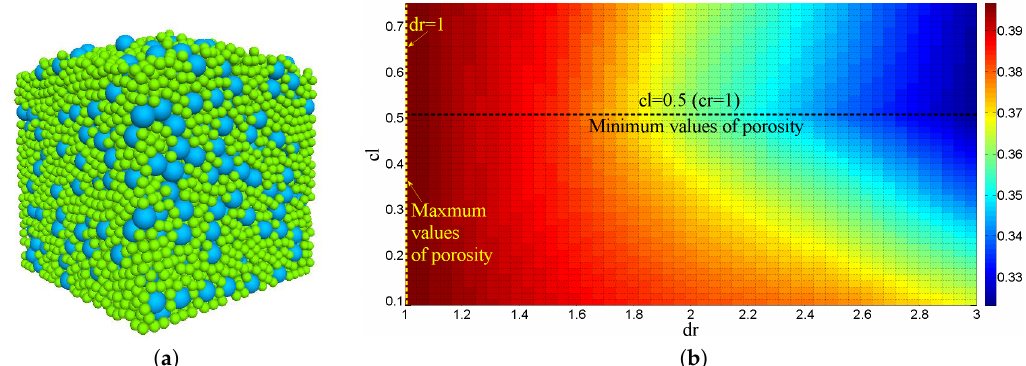
Figure 1. Schematic of ( a ) bi-dispersed packing, and ( b ) its porosity distribution with radius ratio d r and volume fraction ratio c r .